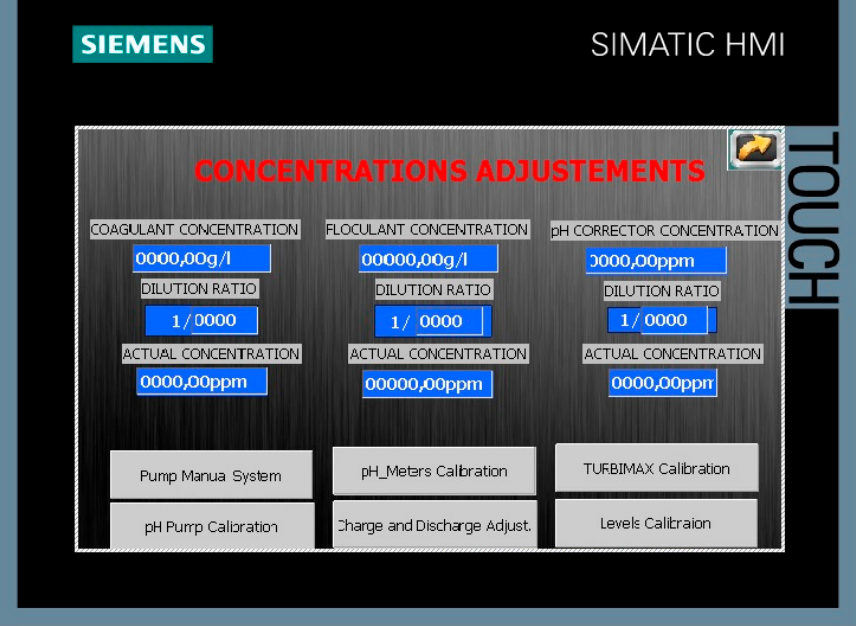
Figure 7. Screen to modify concentrations in the HMI.